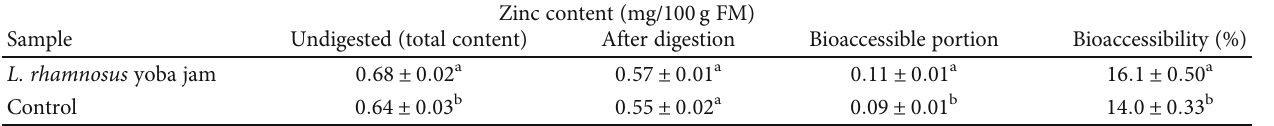
Table 4: In vitro digestion on zinc content of the jam inoculated with L. rhamnosus yoba.